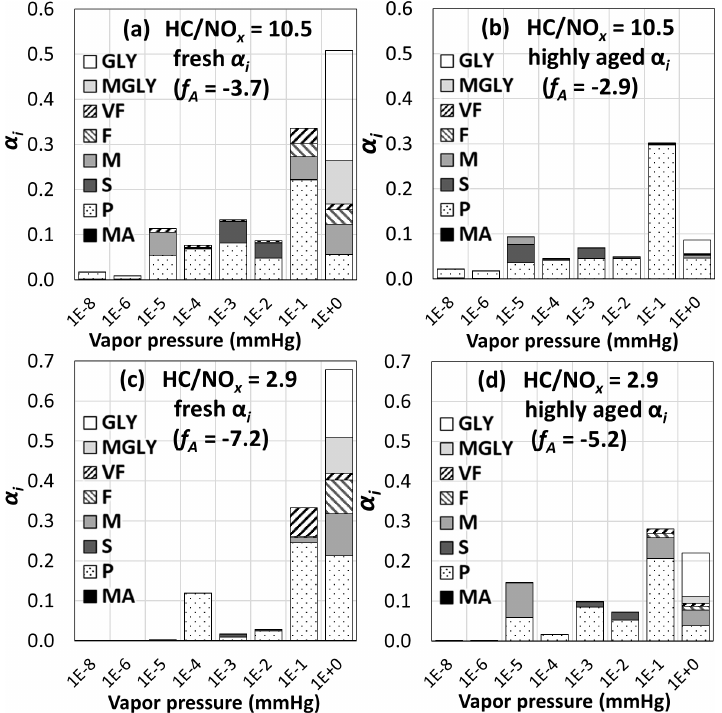
Figure 2. The mass-based stoichiometric coefficients ( α i ) of each lumping species, i , from toluene oxidation (i) under low NO x level (simulation based on the sunlight of Exp. Tol6, HC / NO x = 10.5, 16 December 2018) at (a) fresh condition and (b) highly aged condition and (ii) under high NO x level (simulation based on the sunlight of Exp. Tol8, HC / NO x = 2.9, 30 April 2018) at (c) fresh condition and (d) highly aged condition, where f A is the aging scale factor as derived in Eq. (1) in Sect. 3.1. The oxygenated products predicted by the explicit gas kinetic model are lumped as a function of vapor pressure (eight groups: 10 − 8 , 10 − 6 , 10 − 5 , 10 − 4 , 10 − 3 , 10 − 2 , 10 − 1 , and 1mmHg) and aerosol-phase reactivity (six groups), i.e., very fast (VF: tricarbonyls and α -hydroxybicarbonyls), fast (F: two epoxides or aldehydes), medium (M: one epoxide or aldehyde), slow (S: ketones), partitioning only (P), and multialcohol (MA). MGLY (methylglyoxal) and GLY (glyoxal) were lumped separately due to the relatively high